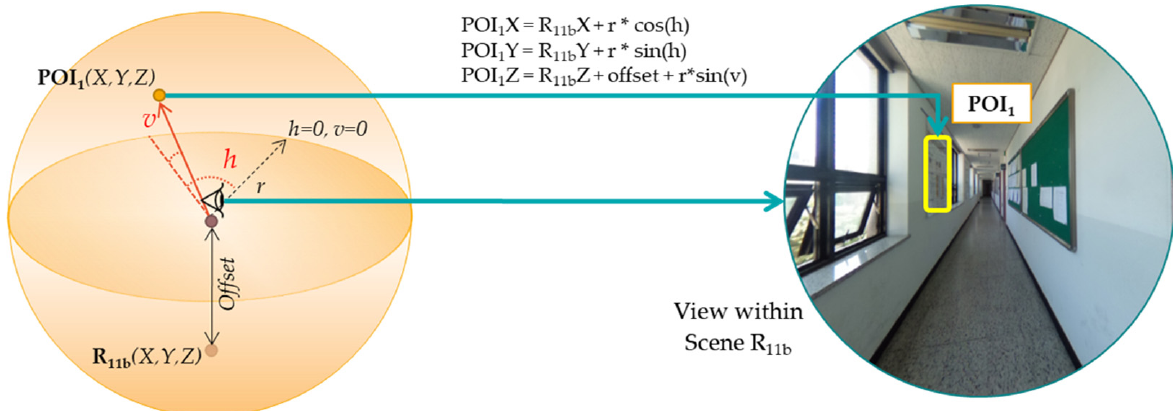
Figure 7. Method of determining local coordinates of indoor POI in the omnidirectional image.